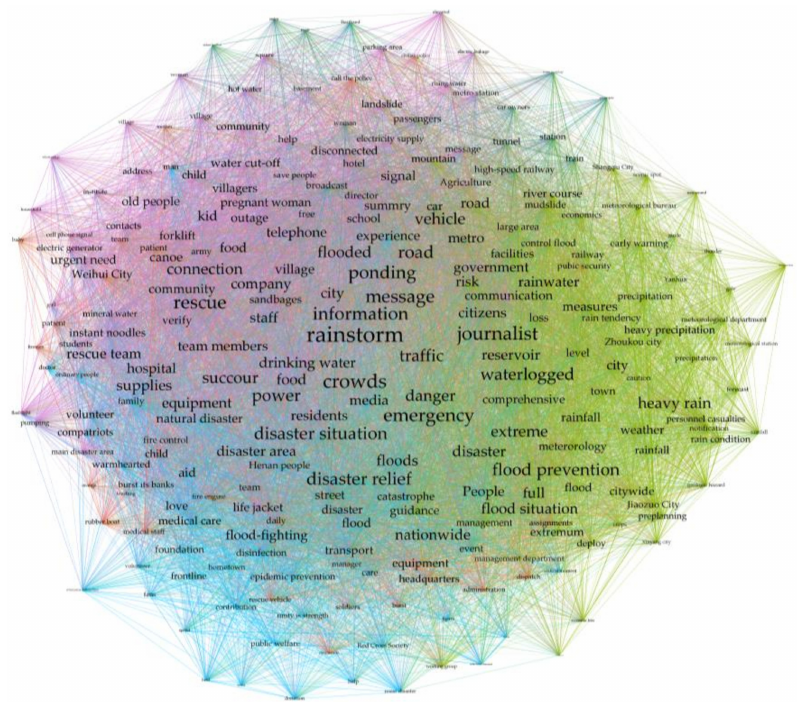
Figure 5. Initial module division diagram of the first 200 keywords in co-occurrence